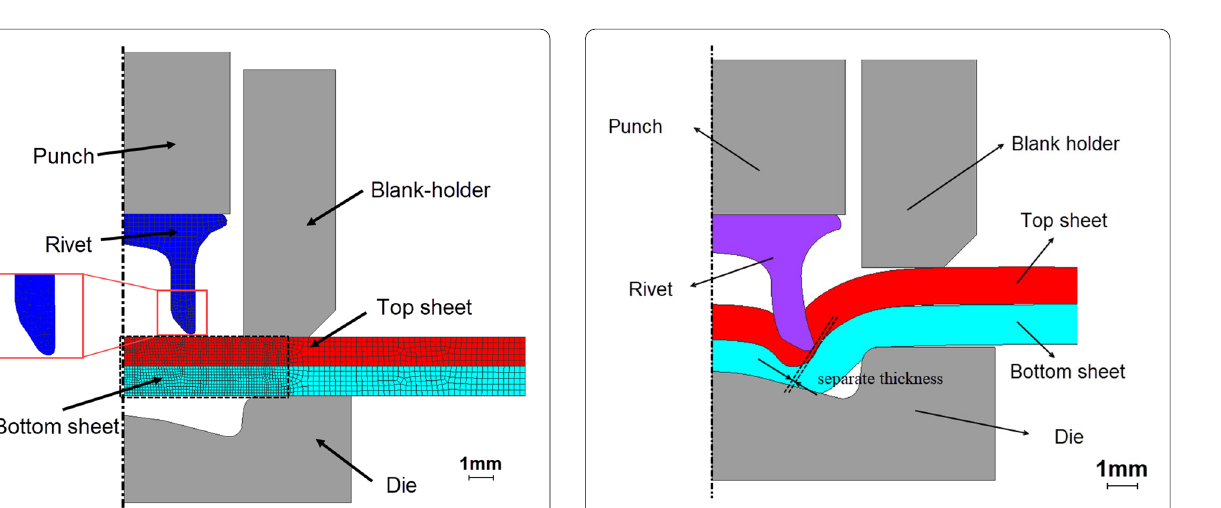
Figure 5 Illustration of the separate thickness for blanking of the top sheet